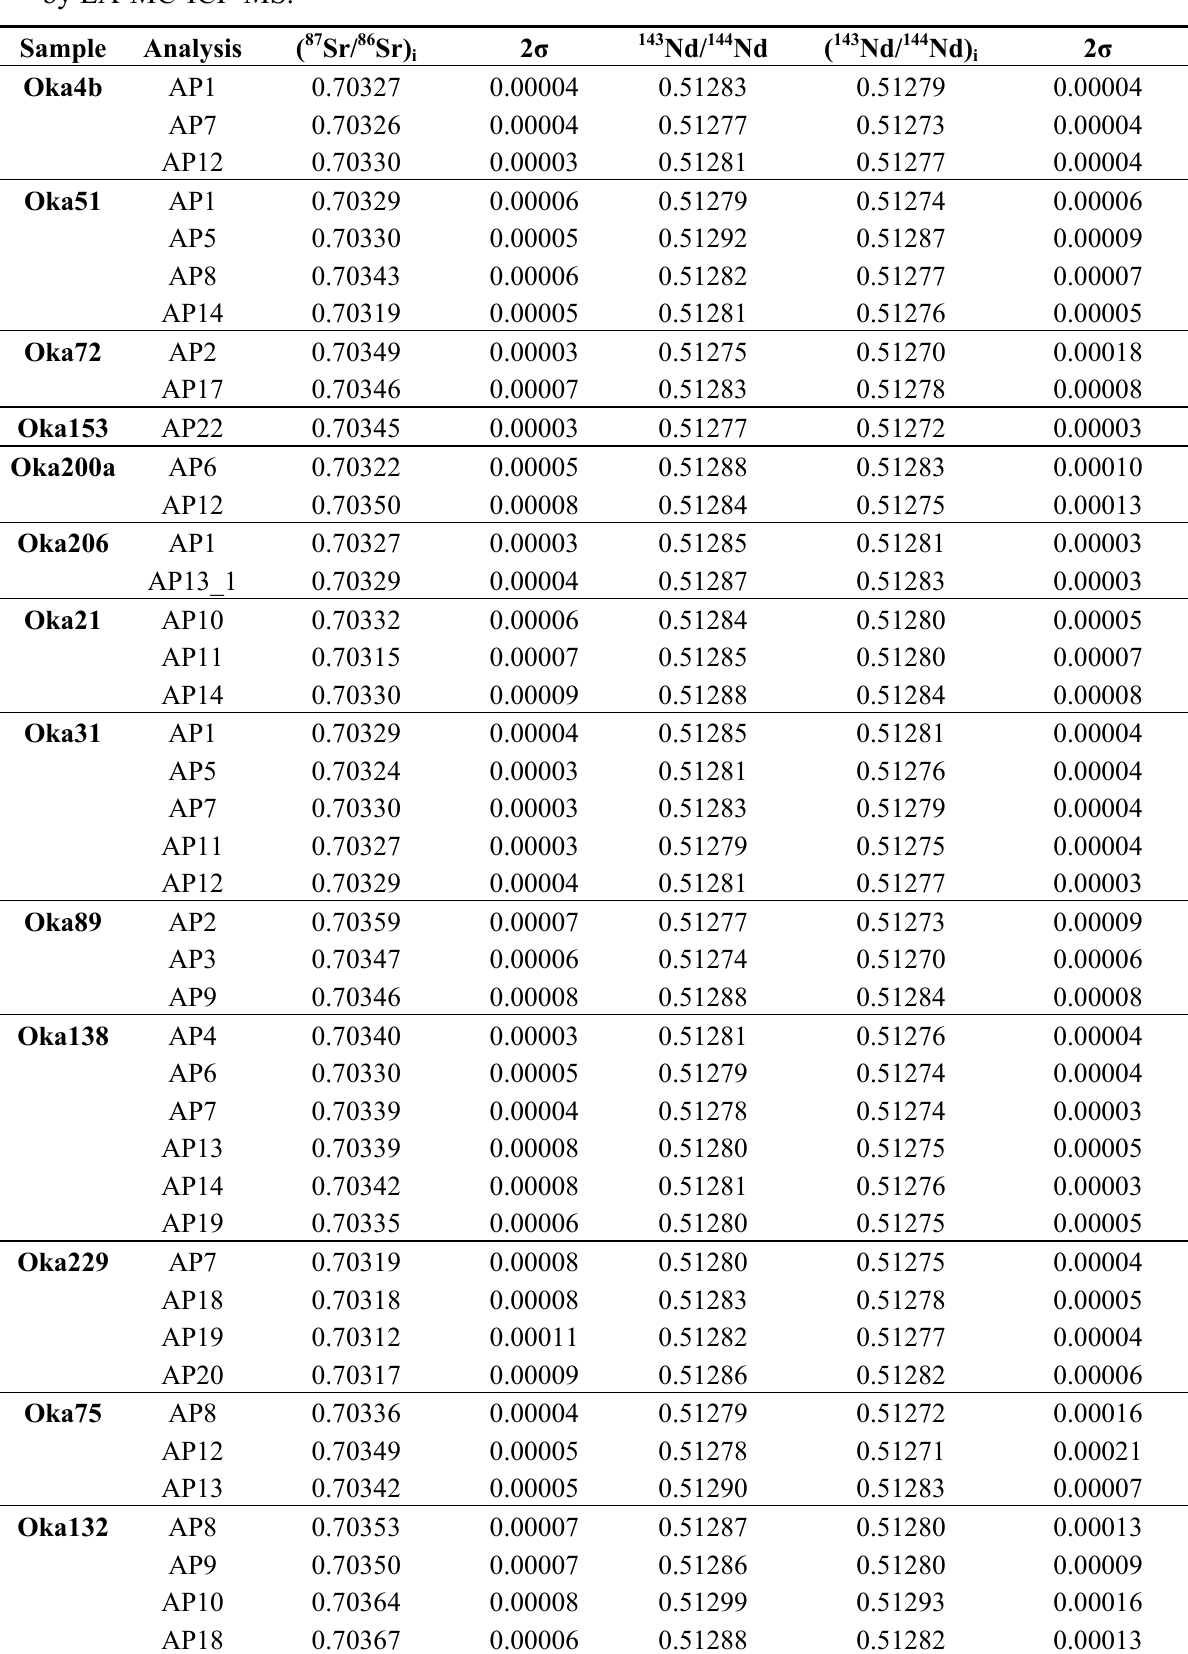
Table 8. In-situ Sr and Nd isotopic compositions for perovskite and apatite by